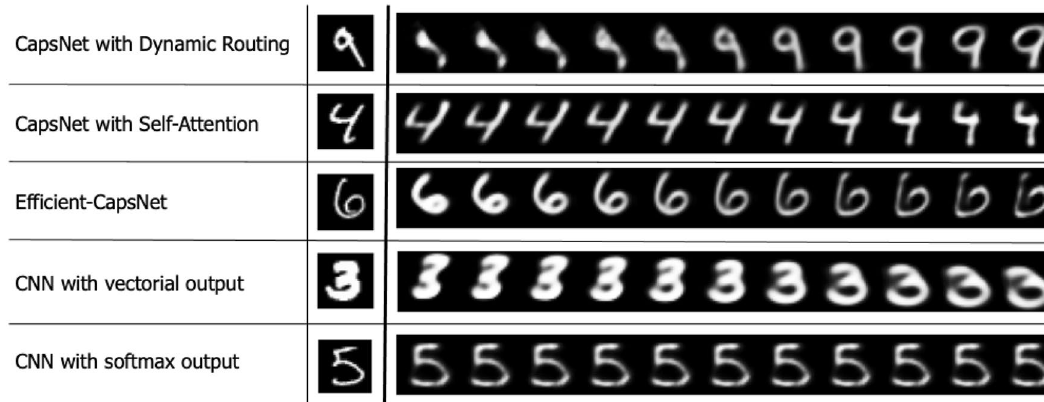
Figure 7. Effect on the digit reconstruction of the addition of perturbations to the output capsule values with different tested methodologies. All networks are able to embed shape, position and orientation information